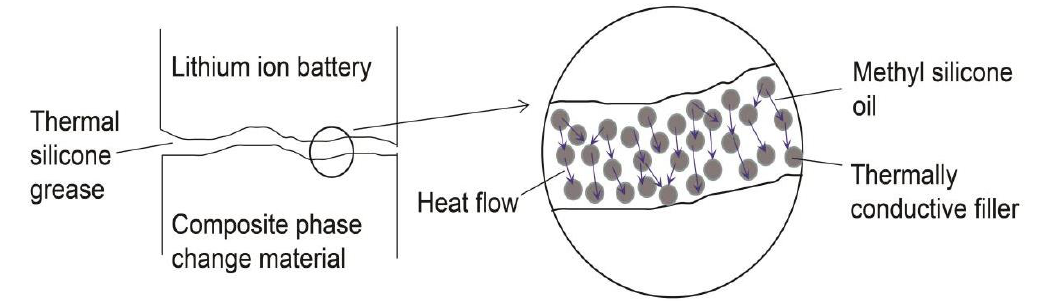
Figure 1. Schematic diagram of heat conduction at the interface of battery/TSG/PCM.